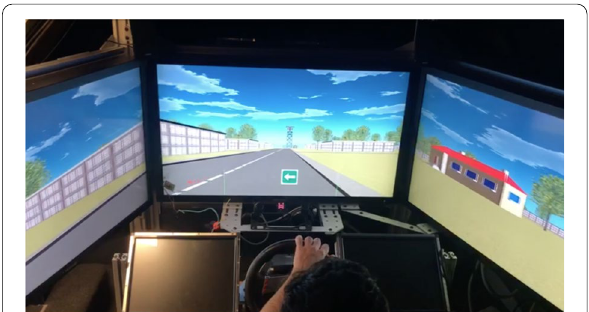
Fig. 1 Driving simulator from the participant’s view as they completed the guided navigation phase of the combined landmark group (PD group). Participants controlled their vehicle with a steering wheel, gas, and brake pedals. The small screens on the left and right of the steering wheel were not used in this experiment. In this example, a tall radar tower at the edge of the town (distal landmark), and a colorful house at the upcoming intersection (proximal landmark) are visible to the driver. A white/green navigation arrow briefly presented at the bottom of the central screen indicates a left turn at the next